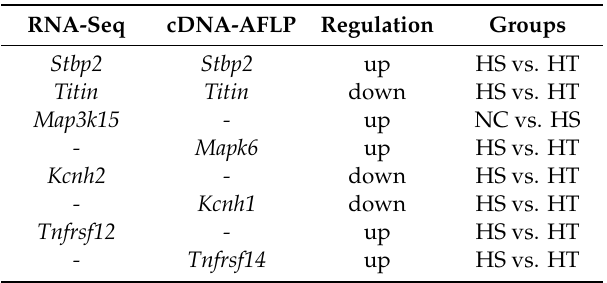
Table 3. Hypoxia-responded genes identified by cDNA-amplified fragment length polymorphism (cDNA-AFLP) [25] and RNA-seq (this study). RNA-Seq cDNA-AFLP Regulation Groups Stbp2 Stbp2 up HS vs. HT Titin Titin down HS vs. HT Map3k15 - up NC vs. HS - Mapk6 up HS vs. HT Kcnh2 - down HS vs. HT - Kcnh1 down Tnfrsf14 HS vs.